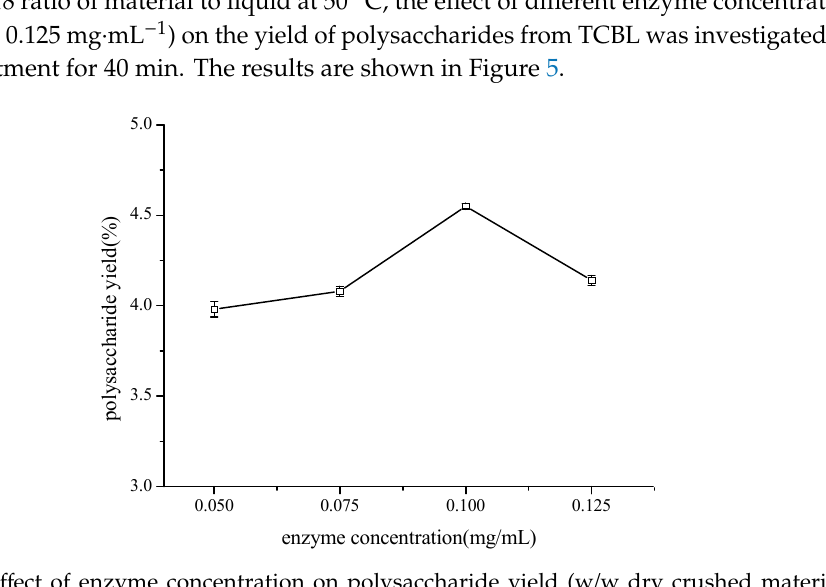
Figure 5. Effect of enzyme concentration on polysaccharide yield (w/w dry crushed material %) from TCBL.